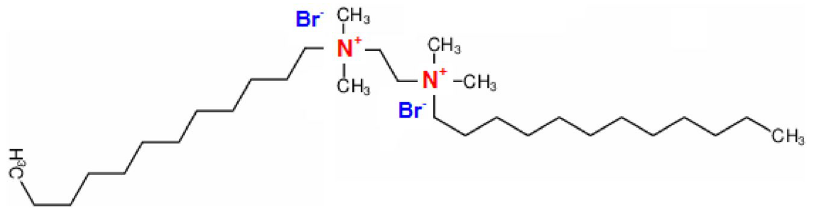
Figure 1. Molecular structure of 1,2-bis(dodecyldimethylammonio) ethane dibromide (DMAEB).